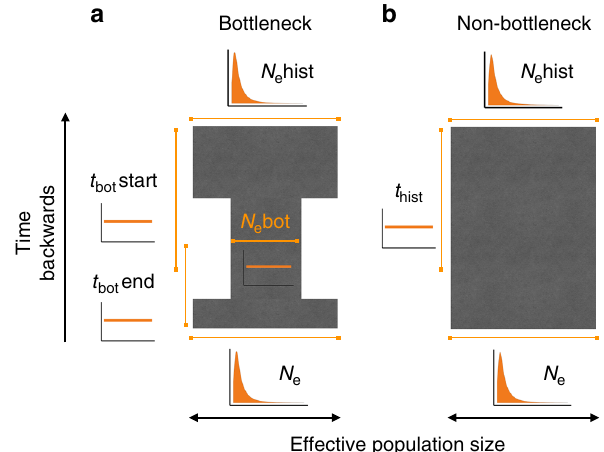
Fig. 6 Schematic representation of two contrasting demographic